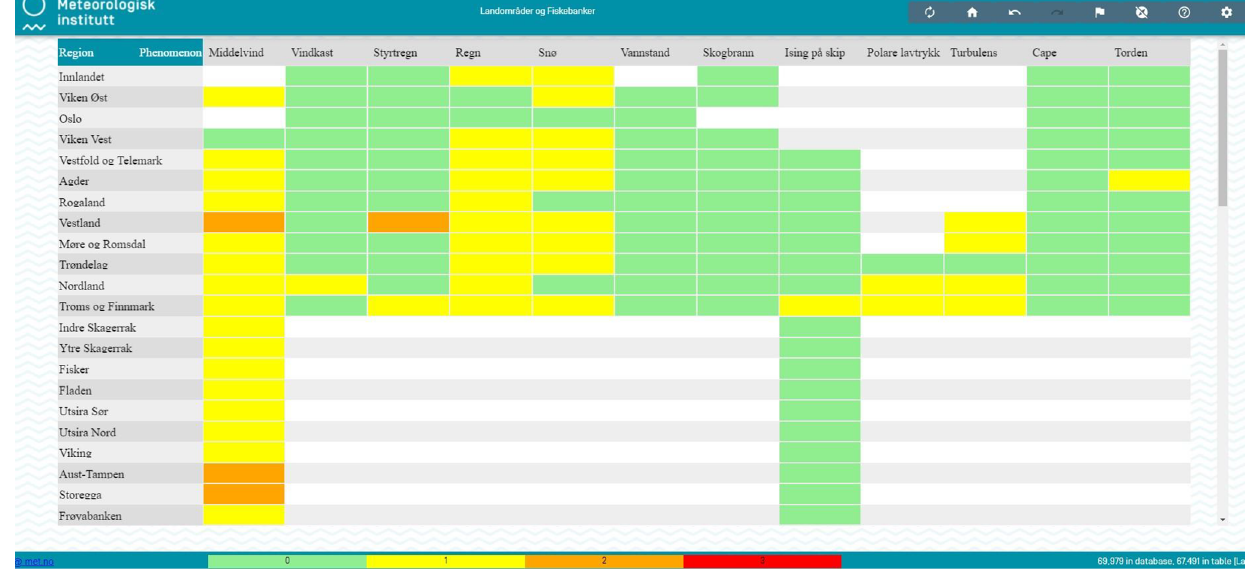
Figure 1. The internal pre-warning alert system at MET Norway (in Norwegian). A table shows selected meteorological parameters and regions. A green colour means that the forecaster can focus on another parameter/region that day, whereas other colours suggest more in-depth exploration. Screenshot by